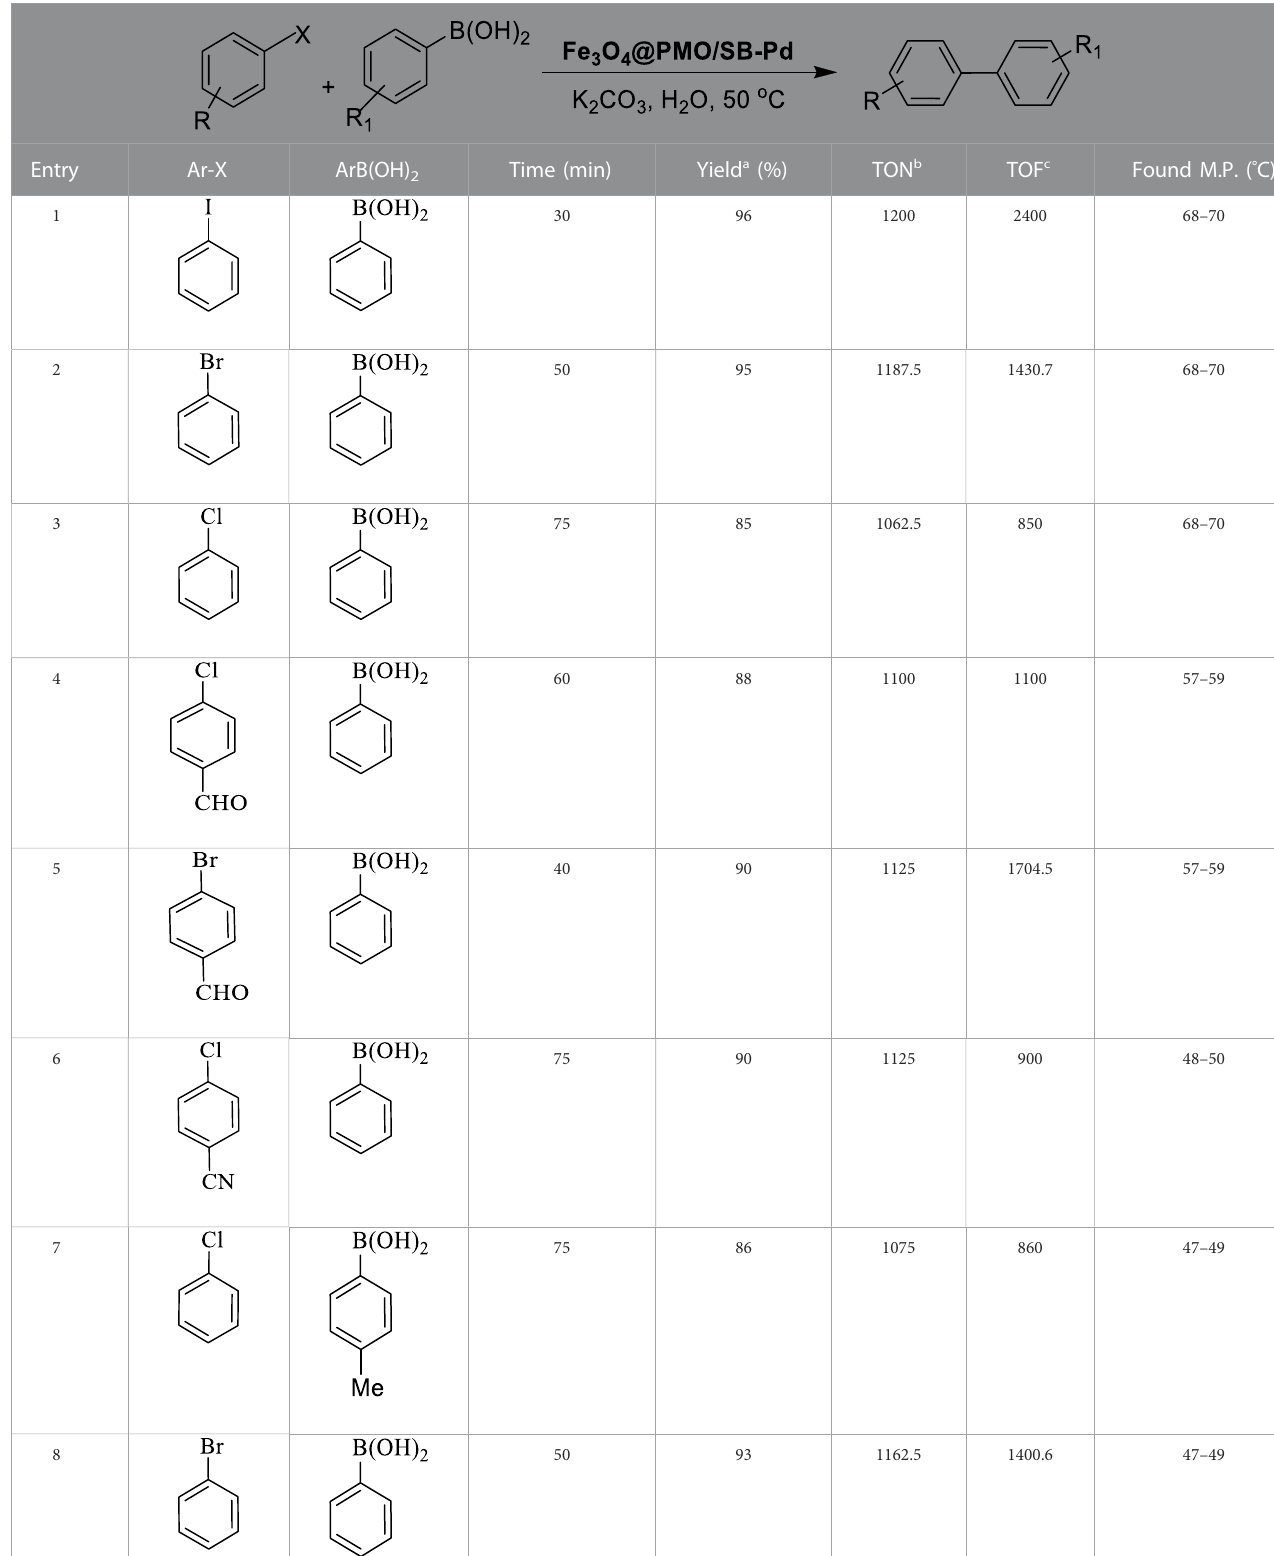
TABLE 2 Suzuki reaction in the presence of Fe 3 O 4